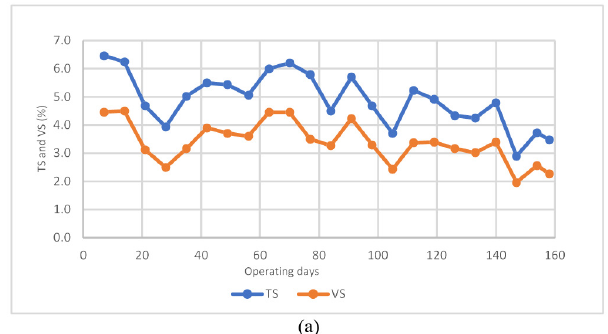
Figure 7. Change in the TS and VS content of ( a ) pig manure, ( b ) food waste, ( c ) excretion, ( d ) thick- ened sewage sludge, and ( e ) mixed